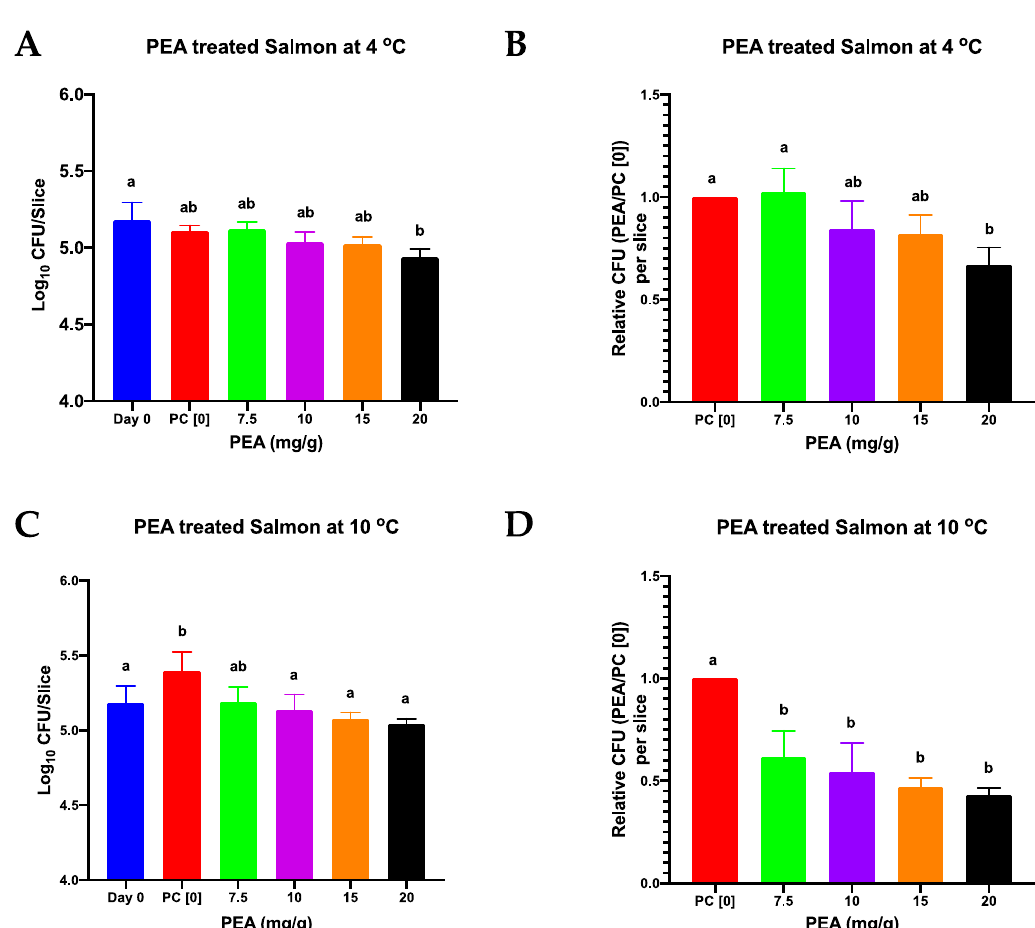
Figure 4. Effect of PEA on bacterial counts on smoked salmon slices treated with varying PEA concentrations and contaminated with a cocktail of four L. monocytogenes strains and stored for 11 days at 4 ◦ C ( A , B ) or 7 days at 10 ◦ C ( C , D ). ( A , C ): Viable bacterial counts were determined and expressed in Log CFU per slice. ( B , D ): CFU levels determined per PEA smoked salmon slice expressed relative to those of the PC [0] slices. PC [0] denotes the positive control sample (PEA untreated, L. monocytogenes inoculated slices). Data shown are the mean (bars) and standard deviation of three biological replicates. Di ff erent letters indicate significant di ff erences ( p < 0.05) that were identified through one-way ANOVA and Tukey post-hoc pairwise comparison test of all the treatment